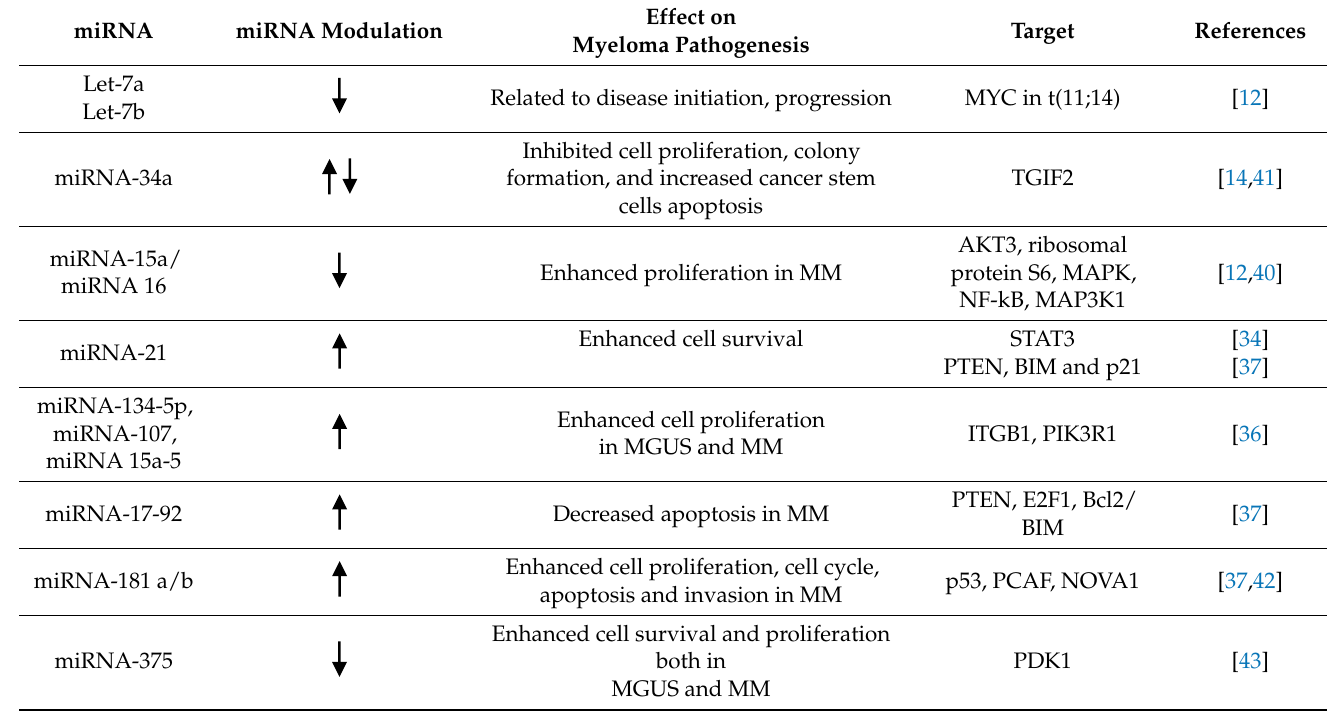
(Table 1). The pathways analysis confirmed the role of miRNAs in oncogenic signaling [36]. Table 1. miRNAs involved in myeloma pathogenesis and their functions.